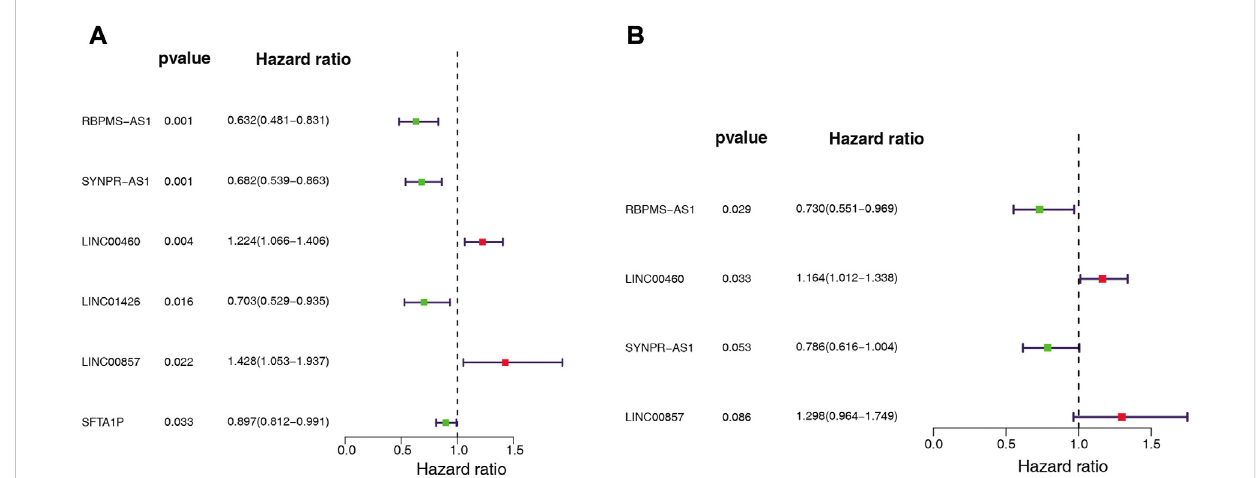
FIGURE 3 Whether ARG-associated DE-lncRNAs is a risk factor for prognosis in LUAD patients was analyzed by (A) univariate and (B) multivariate Cox regression in the TCGA cohort.